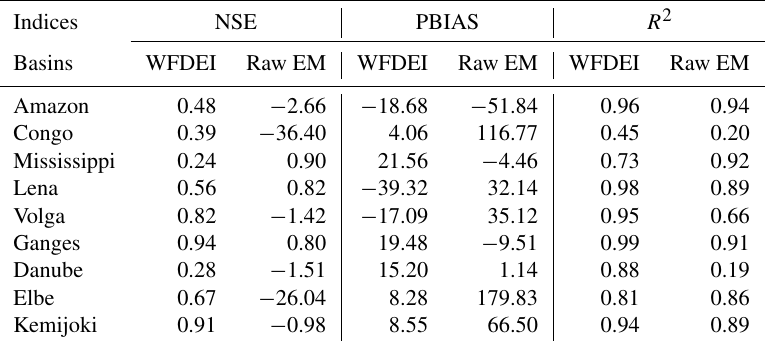
Table 3. Evaluation metrics derived from monthly discharge data. Metrics are calculated for JULES’ simulations from WFDEI data (WFDEI) and the ensemble mean of raw GCM data (raw EM). Indices NSE PBIAS Basins